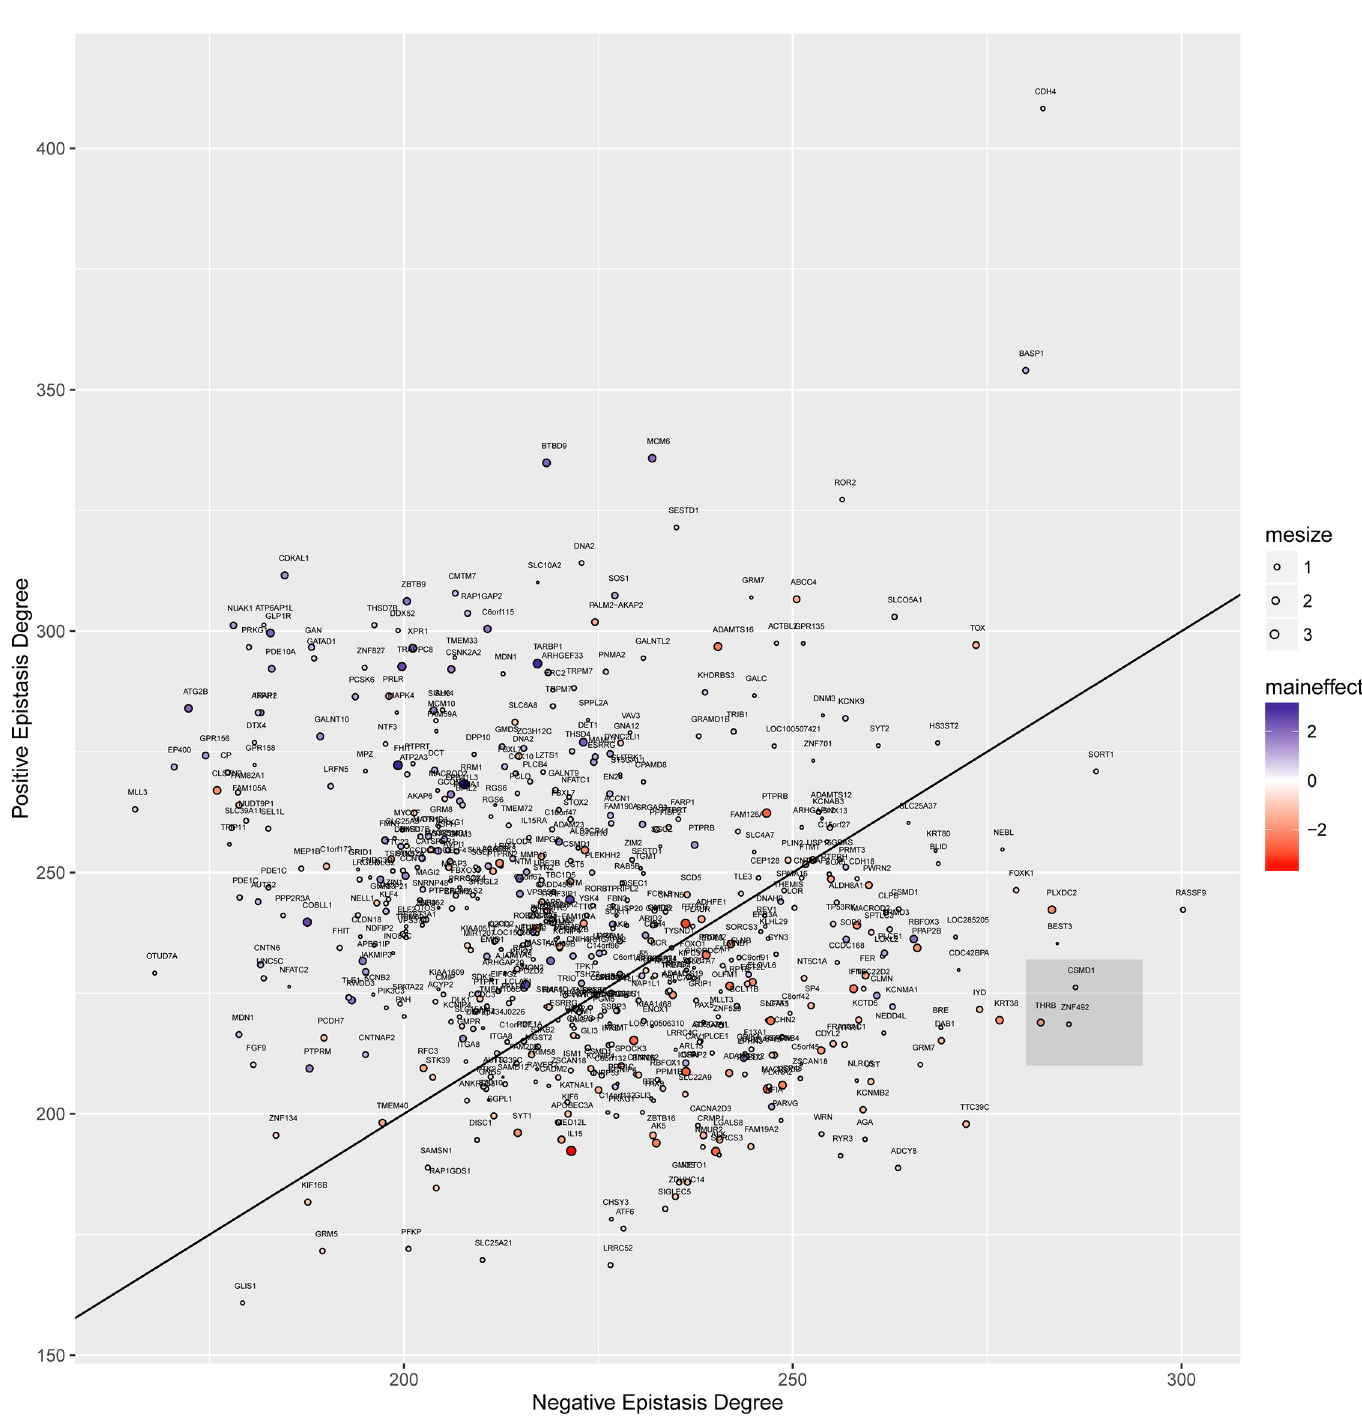
Fig 3. Positive/negative epistasis degree plot shows the overall epistatic network effect and main effect of the top variants for smallpox vaccine immune response. For each variant (mapped to gene symbol), the sum of positive interaction coefficients (positive epistasis degree) versus negative epistasis degree is plotted. The diagonal is the line of zero sum of epistasis degree. Plot symbols (size and color) are labeled by their main effect (magnitude and direction of effect on vaccine immune response). The gray box highlights the THBR variant.